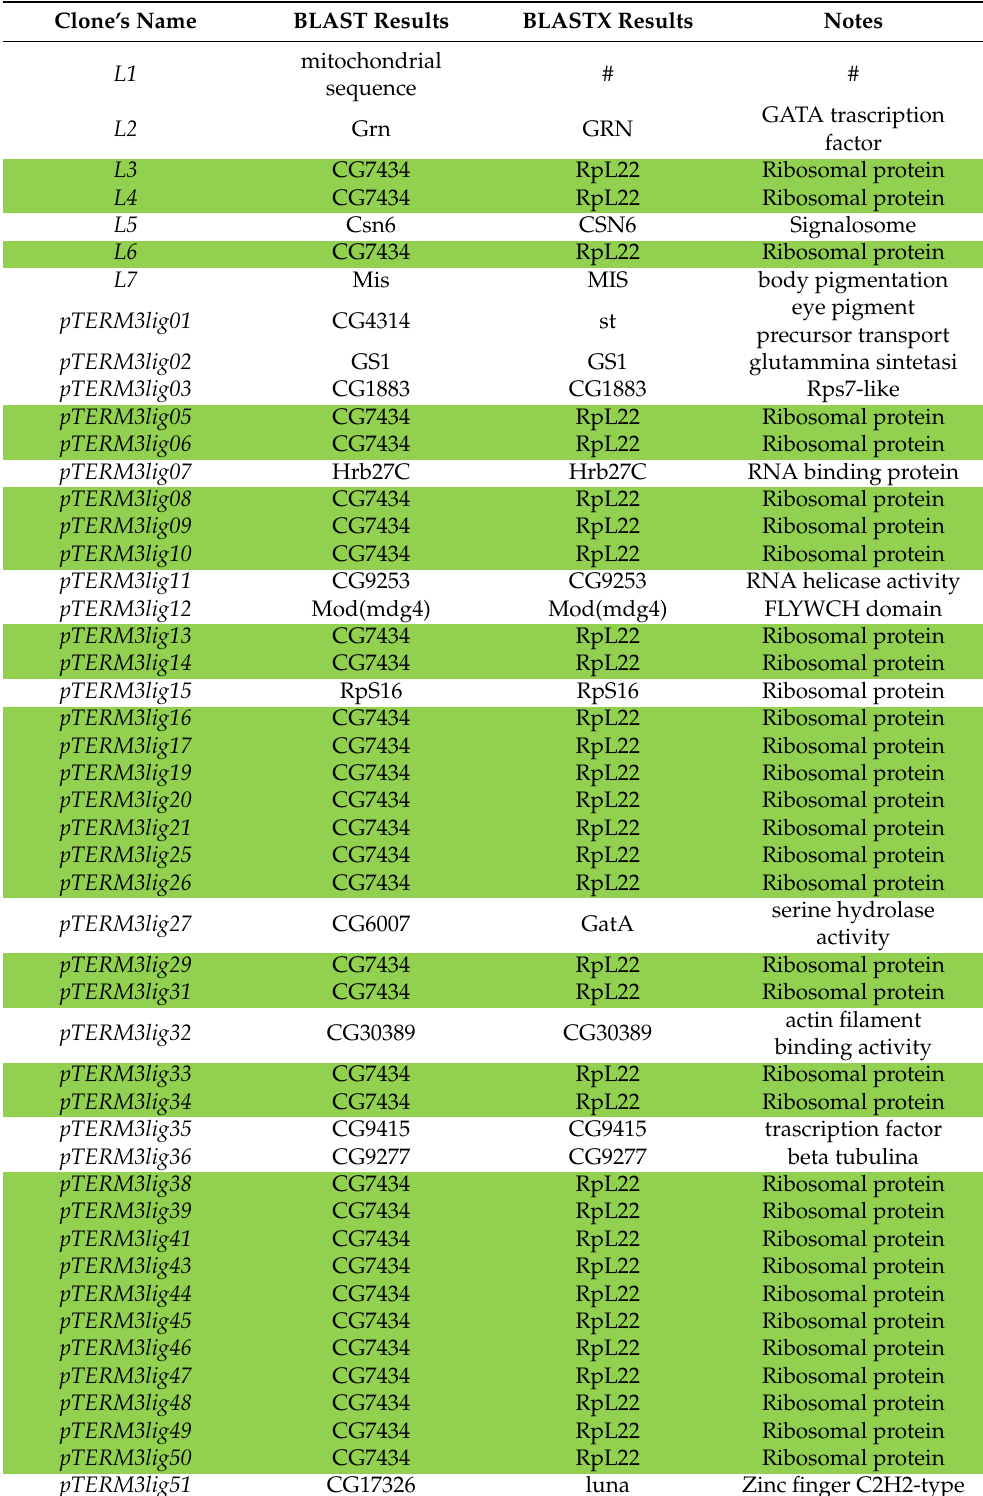
Table 1. Yeast One-Hybrid assay